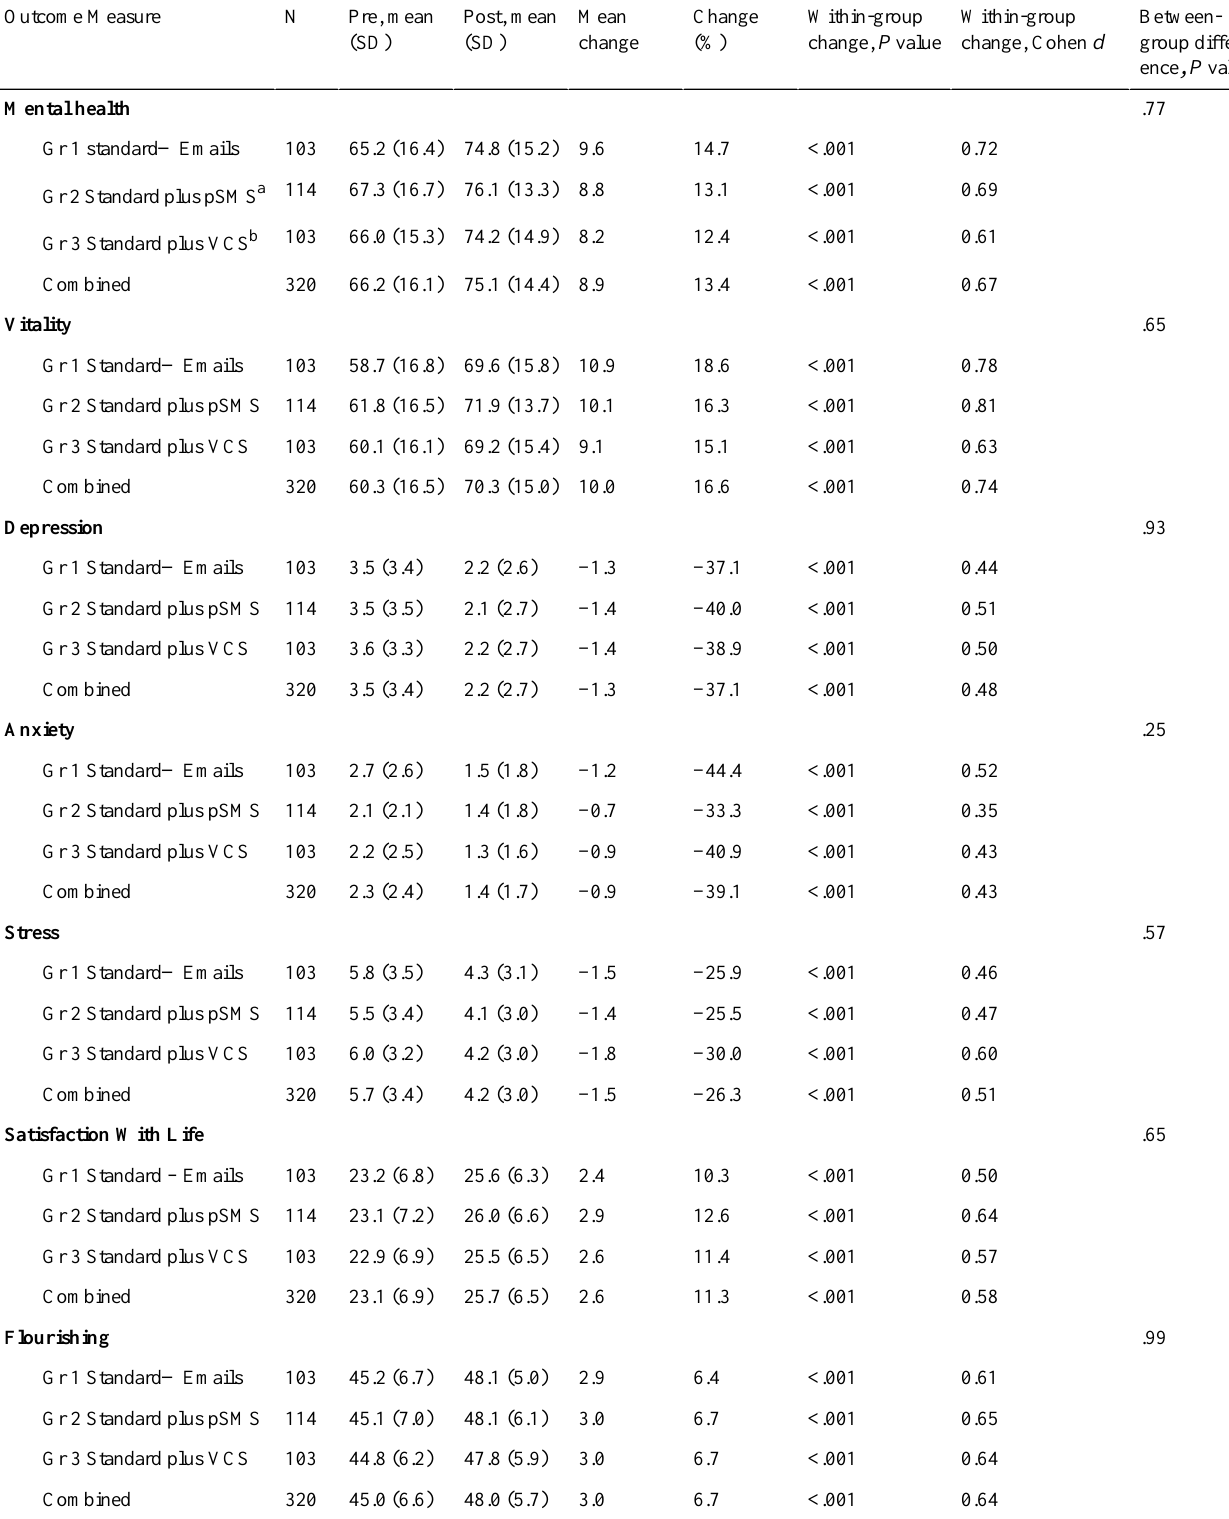
Table 3. Pre- to postchanges in outcome measures of participants and between-group differences.